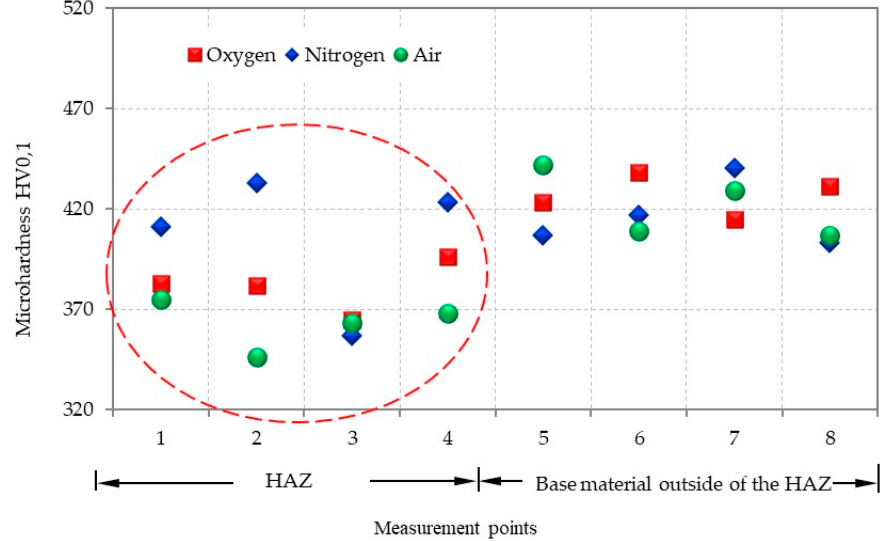
Figure 3. Indentation points for measuring microhardness (cross-section).